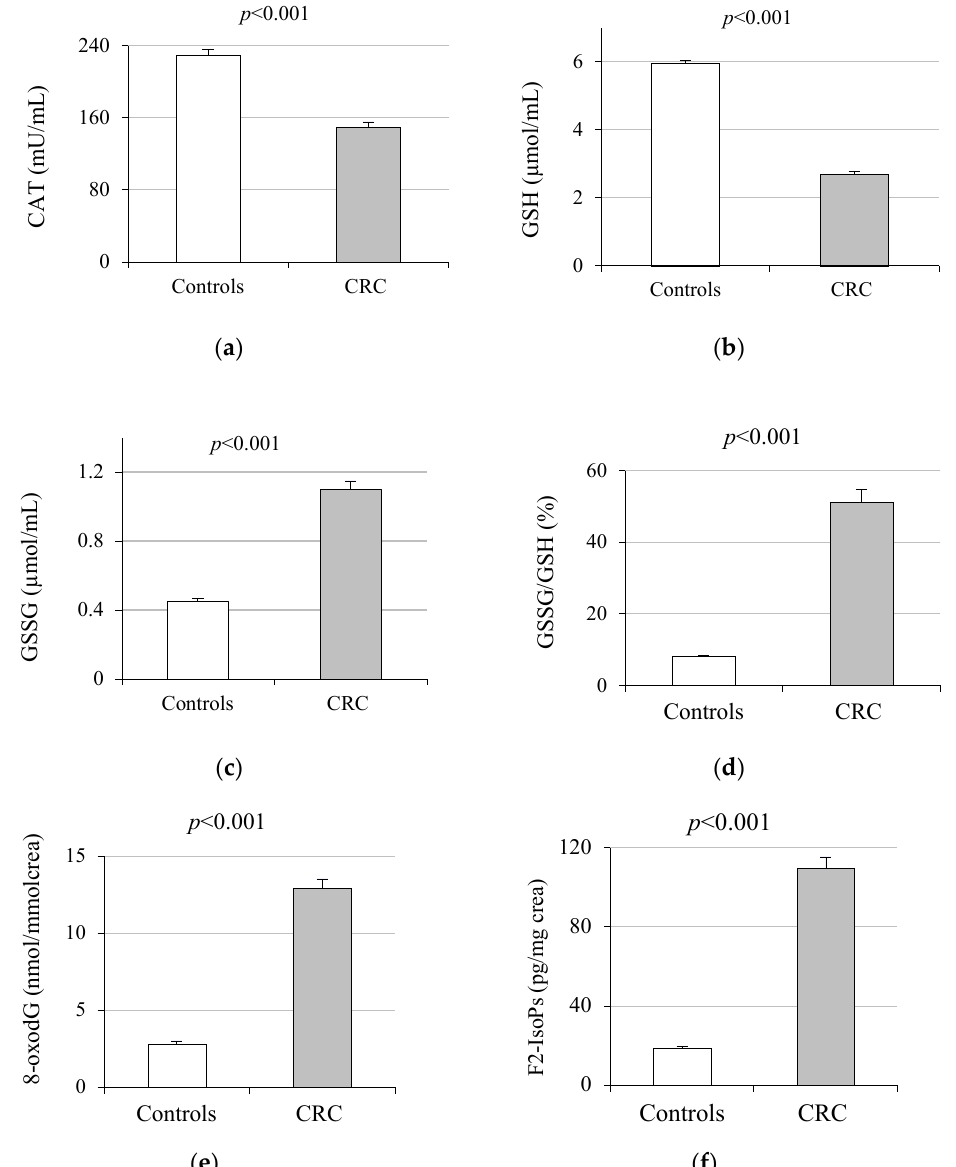
Figure 1. Levels of serum catalase ( a ); reduced glutathione ( b ); oxidized glutathione ( c ); GSSG/GSH ratio ( d ); and urine 8-oxo-7,8-dihydro-2′-deoxyguanosine ( e ) and F2-IsoProstanes ( f ) in controls and CRC patients; p -value adjusted for age and body mass index. Data are expressed as mean ± standard error. CAT: catalase; GSH: reduced glutathione; GSSG: oxidized glutathione; 8-oxodG: 8-oxo-7,8-dihydro-2′-deoxyguanosine; F2-IsoPs: F2-IsoProstanes.